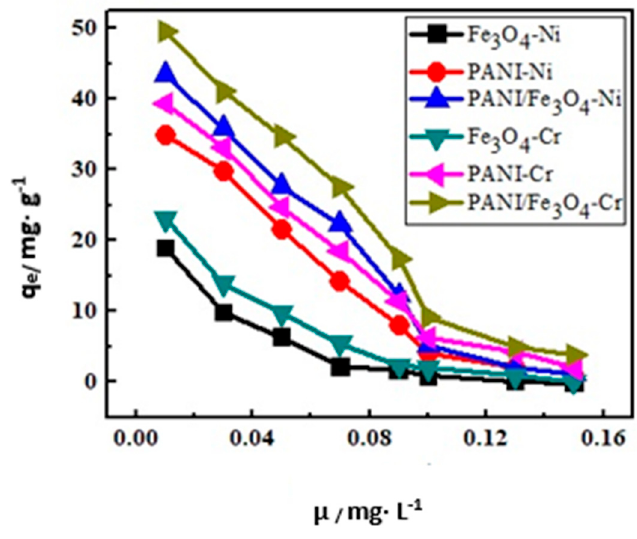
Figure 9. E ff ect of other ions on adsorption of Cr(VI) and Figure 9. Effect of other ions on adsorption of Cr(VI) and Ni(II).